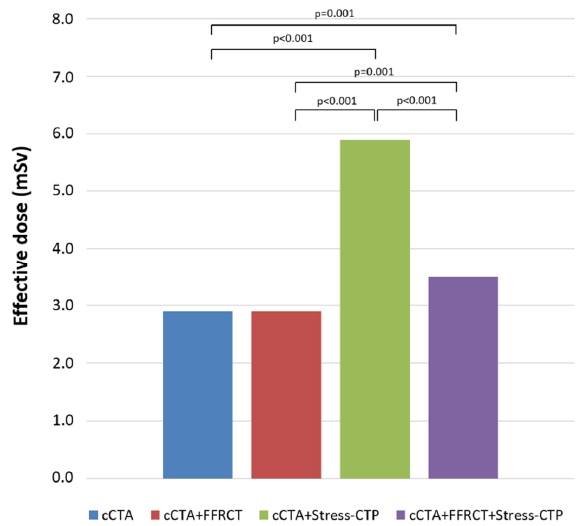
Figure 8. Radiation exposure. In terms of radiation exposure, the cCTA + Stress-CTP strategy was associated with the highest ED with a progressive reduction in the ED for cCTA + FFR CT + Stress-CTP and cCTA + FFR CT . cCTA: coronary computed tomography angiography; Stress-CTP: stress computed tomography perfusion, ED: effective dose; FFR CT : computed tomography-derived fractional flow reserve.